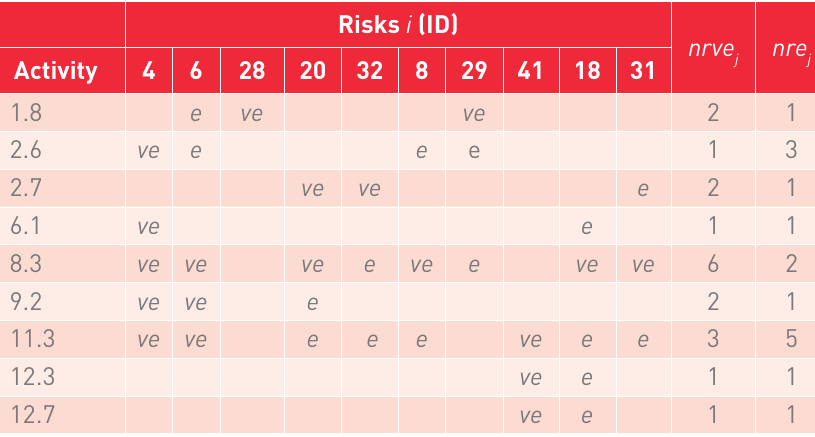
Influence degrees of risks on the activities in terms of effective ( e ) or very effective ( ve )